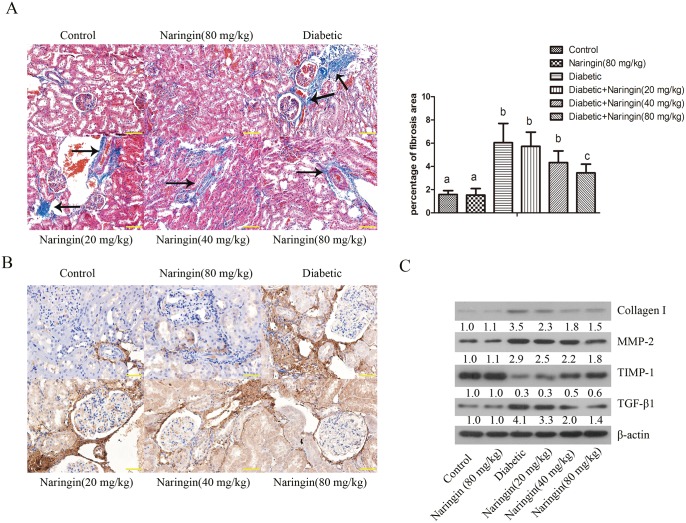
Naringin inhibited collagen production and renal interstitial fibrosis.(A) The collagen deposition and renal interstitial fibrosis was observed by Masson’s staining(200×). The percentages of fibrosis area were shown. (B) The expression of collagen I in kidney tissues was determined by immunohistochemical staining(400×). (C) The expressions of collagen I, MMP-2, TIMP-1 and TGF-β1 in kidney tissues were detected by western blot. Results represent three independent experiments. Data were expressed as means ± SD, n = 6.a-c Means with different superscripts are significantly different (P< 0.05).